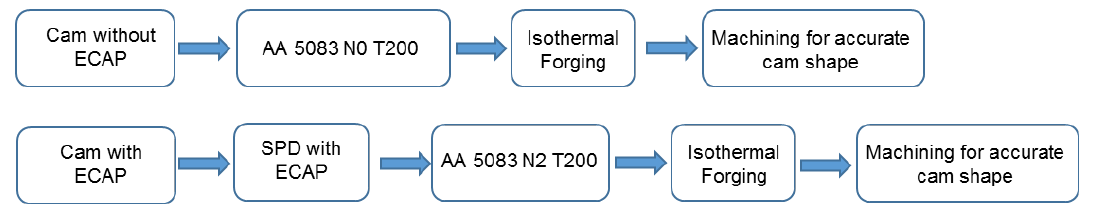
Figure 2. Manufacturing process to obtain the cams with and without previous ECAP processing, where in both study cases, AA5083 was firstly subjected to a heat treatment of annealing.